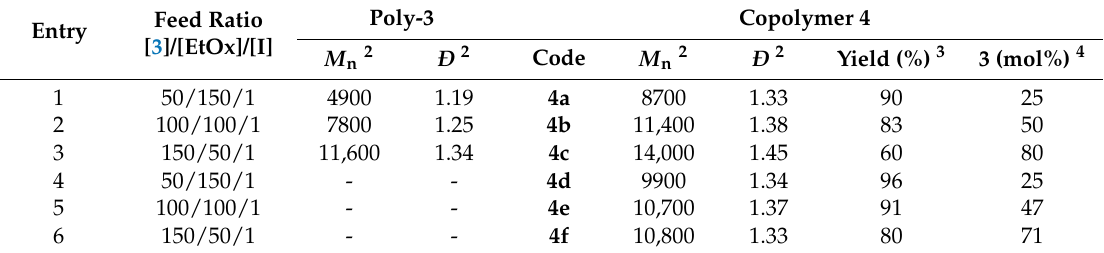
Table 1. Copolymerization results of 3 with 2-ethyl-2-oxazoline (EtOx) initiated with Sc(OTf) 3 1 .